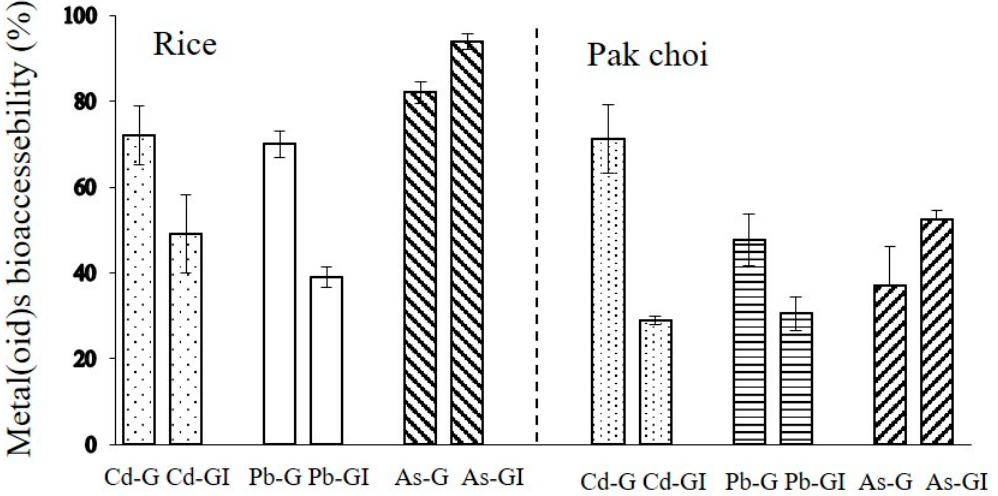
Figure 4. The metal(loid)s bioaccessibility (%, n = 3, means ± SD) in rice and pak choi established by the physiologically based extraction test (PBET) method (G is for gastric phase and I is for gastrointestinal phase).